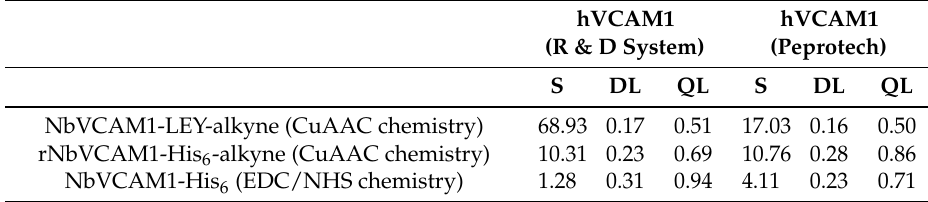
Table 1. The sensitivity (S), detection limit (DL) and quantitation limit (QL), all displayed in µ g/mL, for the binding of recombinant human VCAM1 antigens to the nanobody-conjugated flow cells prepared by the different coupling methods.